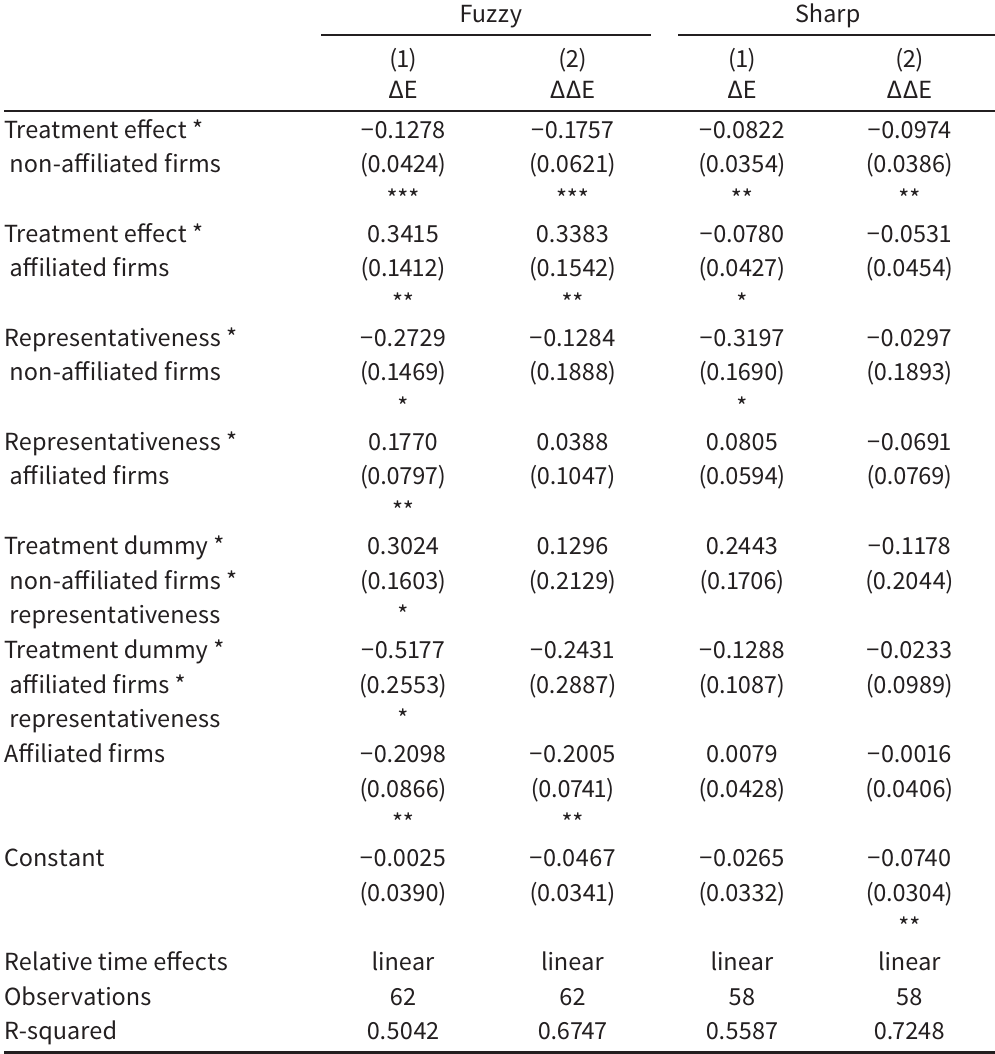
Panel A. Results on the role of representativeness by affiliation status